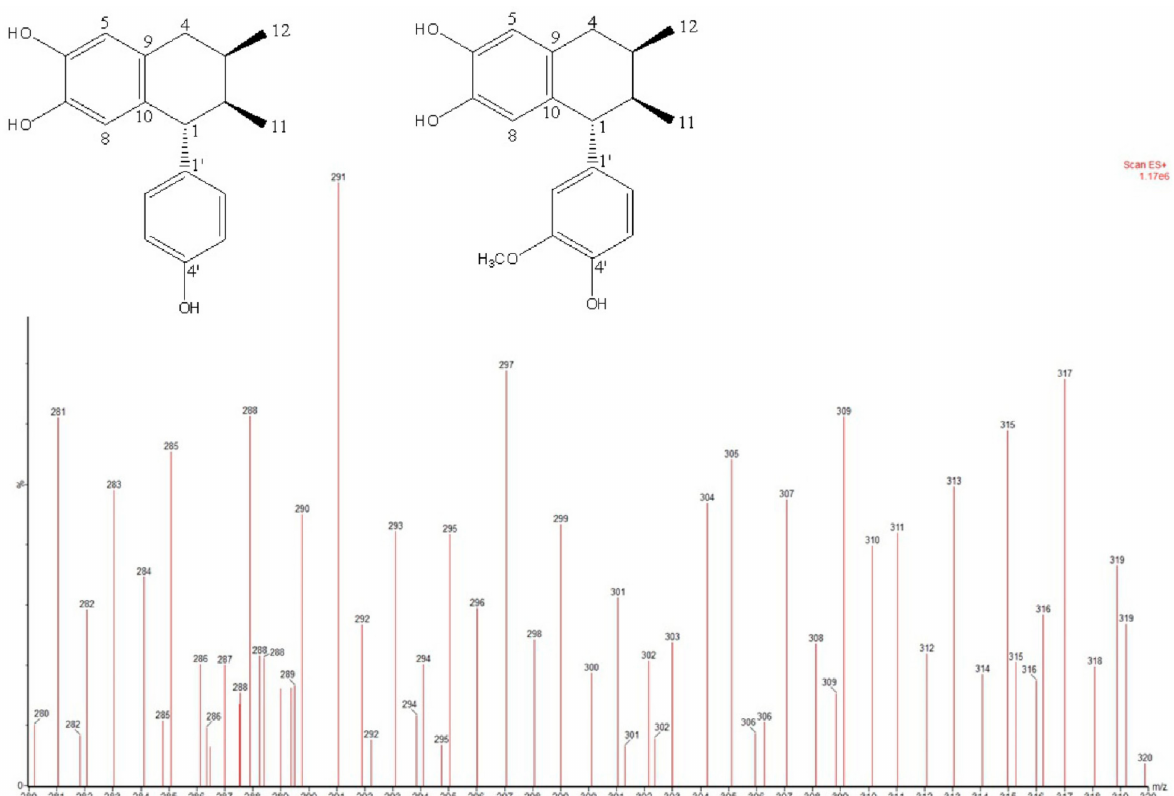
Figure A7. Mass spectrum (MS) of 3 (cid:48) -demethoxy-6-O-demethylisoguaiacin ( 1 ) and 36 norisoguaiacin ( 2